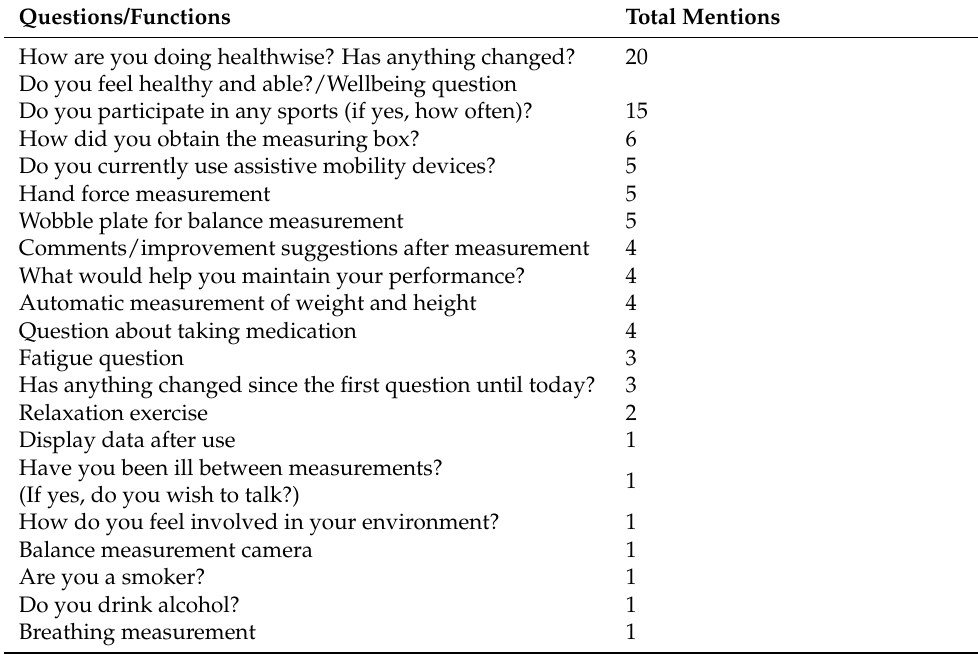
Table 4. Derived questions and functions for further